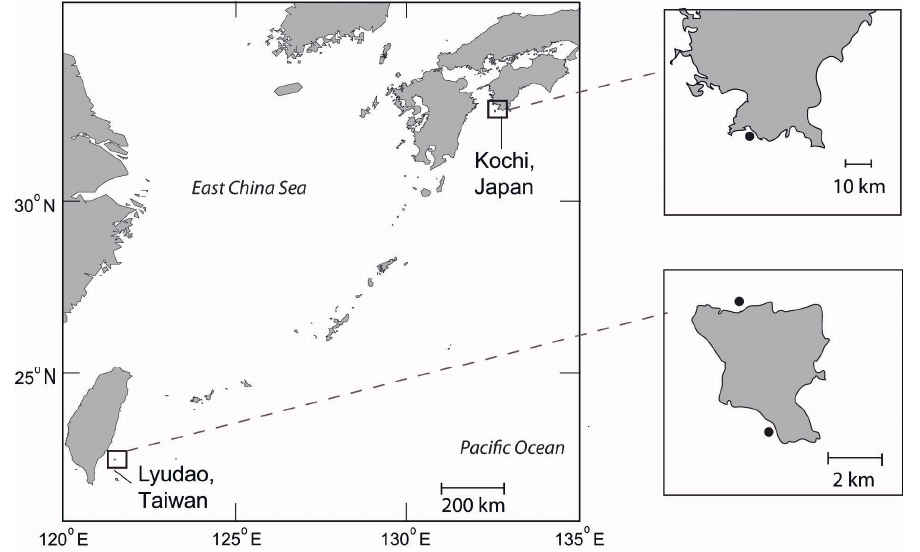
Figure 1. Map of the study region in Southeast Asia, including the two study locations: Lyudao (Taiwan) and Kochi (Japan). The black dots indicate the collection sites Da-Bai-Sa and Chai-Kou in Lyudao (resp. the southwest and the north) and in front of the Biological Institute on Kuroshio in Nishidomari, Kochi.